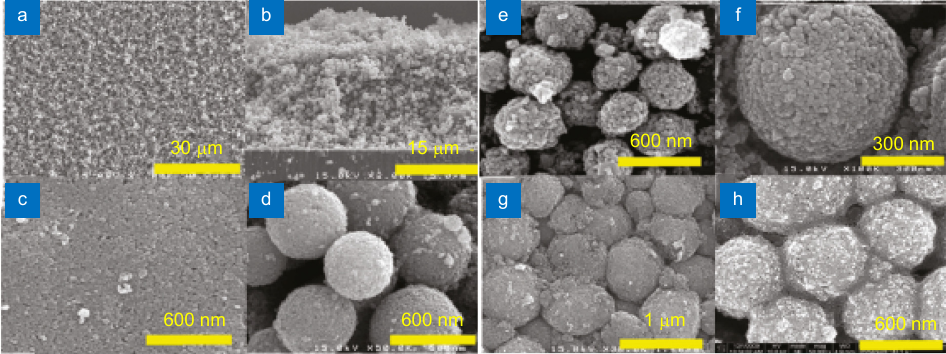
Fig. 12 | SEM images of (a) crack-free photoelectrode of HS TiO 2 spheres, (b) cross-sectional image of the HS-TiO 2 layer, (c) the non-structured TiO 2 layer by electrospray. (d) HS-TiO 2 with diameter of 640 nm. (e) HS-TiO 2 with diameter of 260 nm. (f) A HS-TiO 2 of nanoclusters of P25. (g) After heat treatment at 120 °C (for 10 min), and (h) post-treated HS-TiO 2 layer with TiCl 4 aq. solution 100